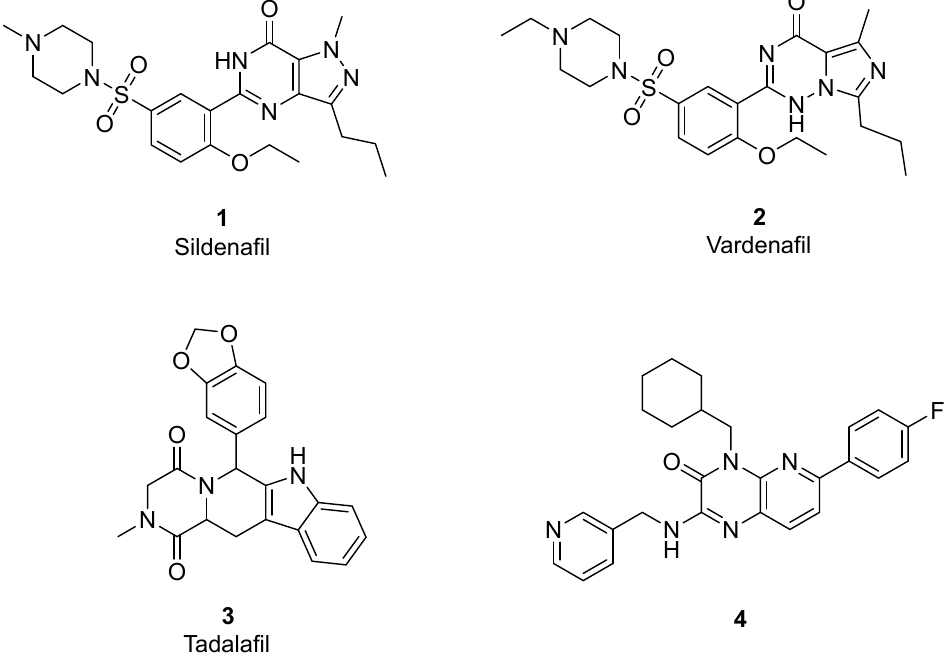
Figure 1. Reported PDE5 inhibitors.